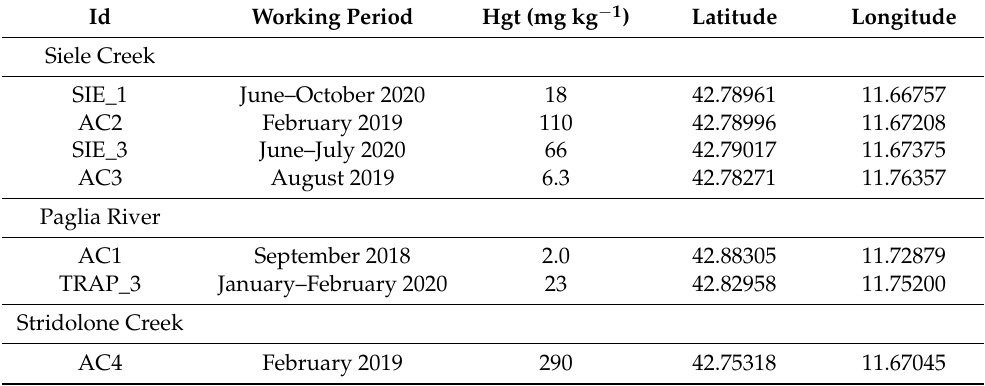
Table 4. Bedload trap location and total Hg (mg kg − 1 ) concentrations in sediments collected in the bedload